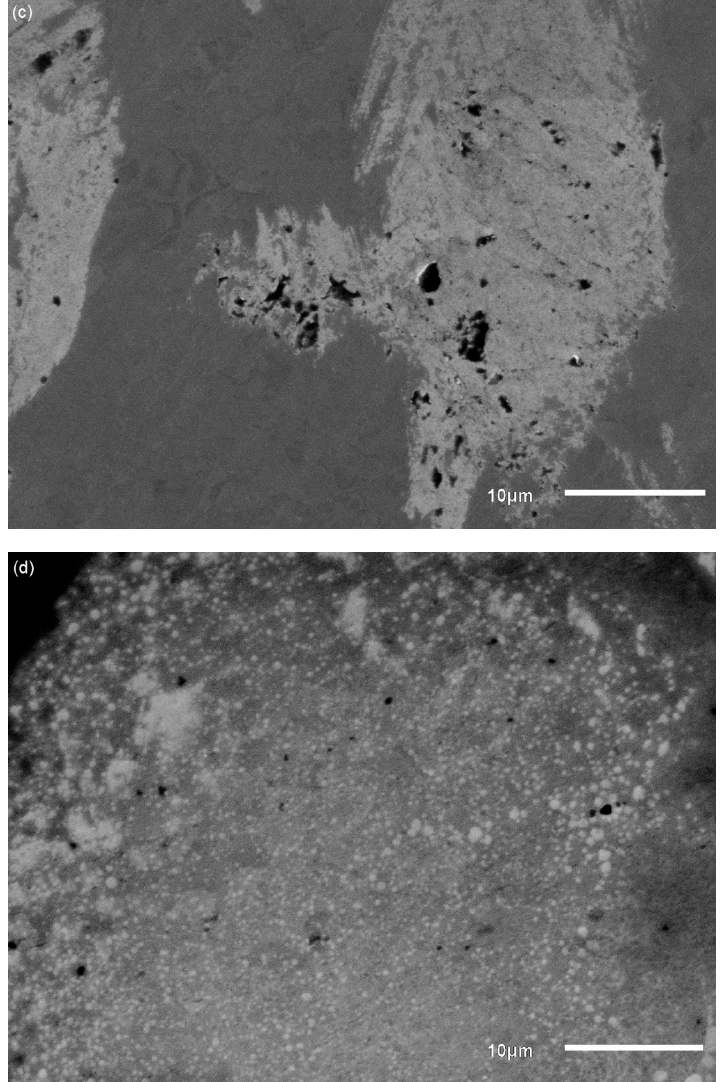
Figure 11. SEM images of coupons after biofilm removal after immersion in pH 7 ( a ); pH 8 ( b ); pH 9 ( c ); pH 10 ( d ) environments (black circular areas represent pit formation). Table 3. Element concentrations (mass %) of coupons with biofilm immersed in different pH environments.